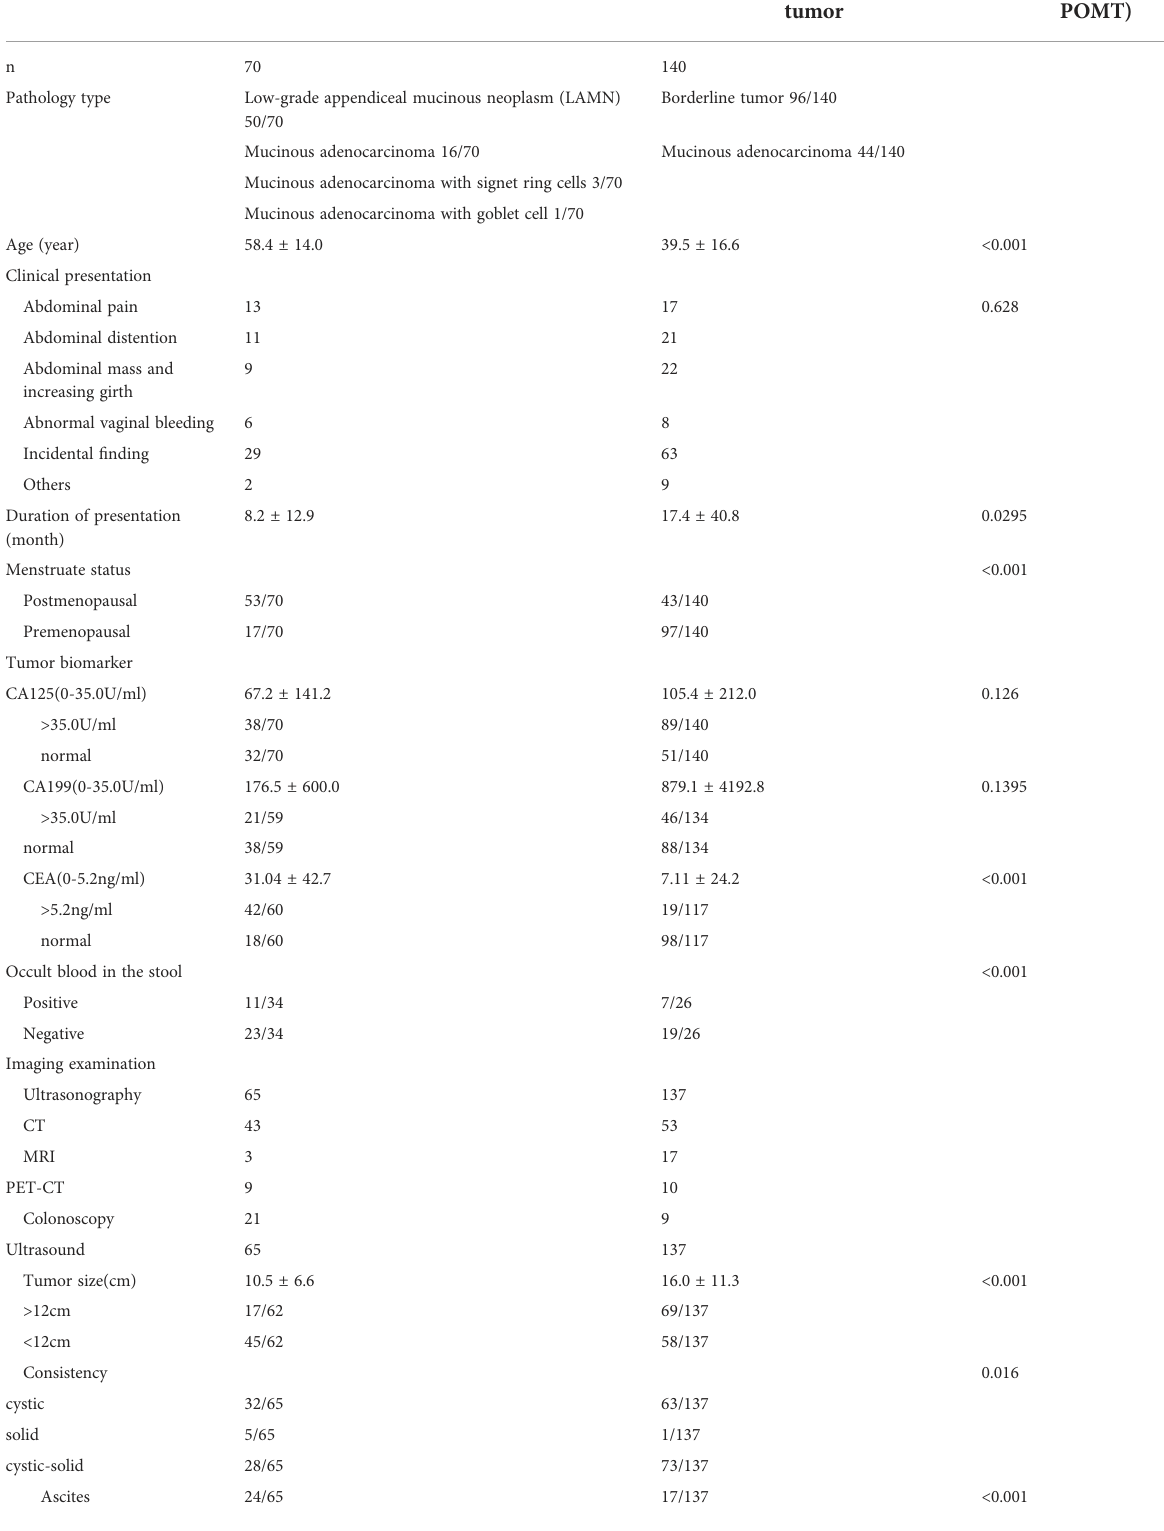
TABLE 1 Preoperative characteristics of the primary ovarian mucinous tumors and misdiagnosed appendiceal mucinous